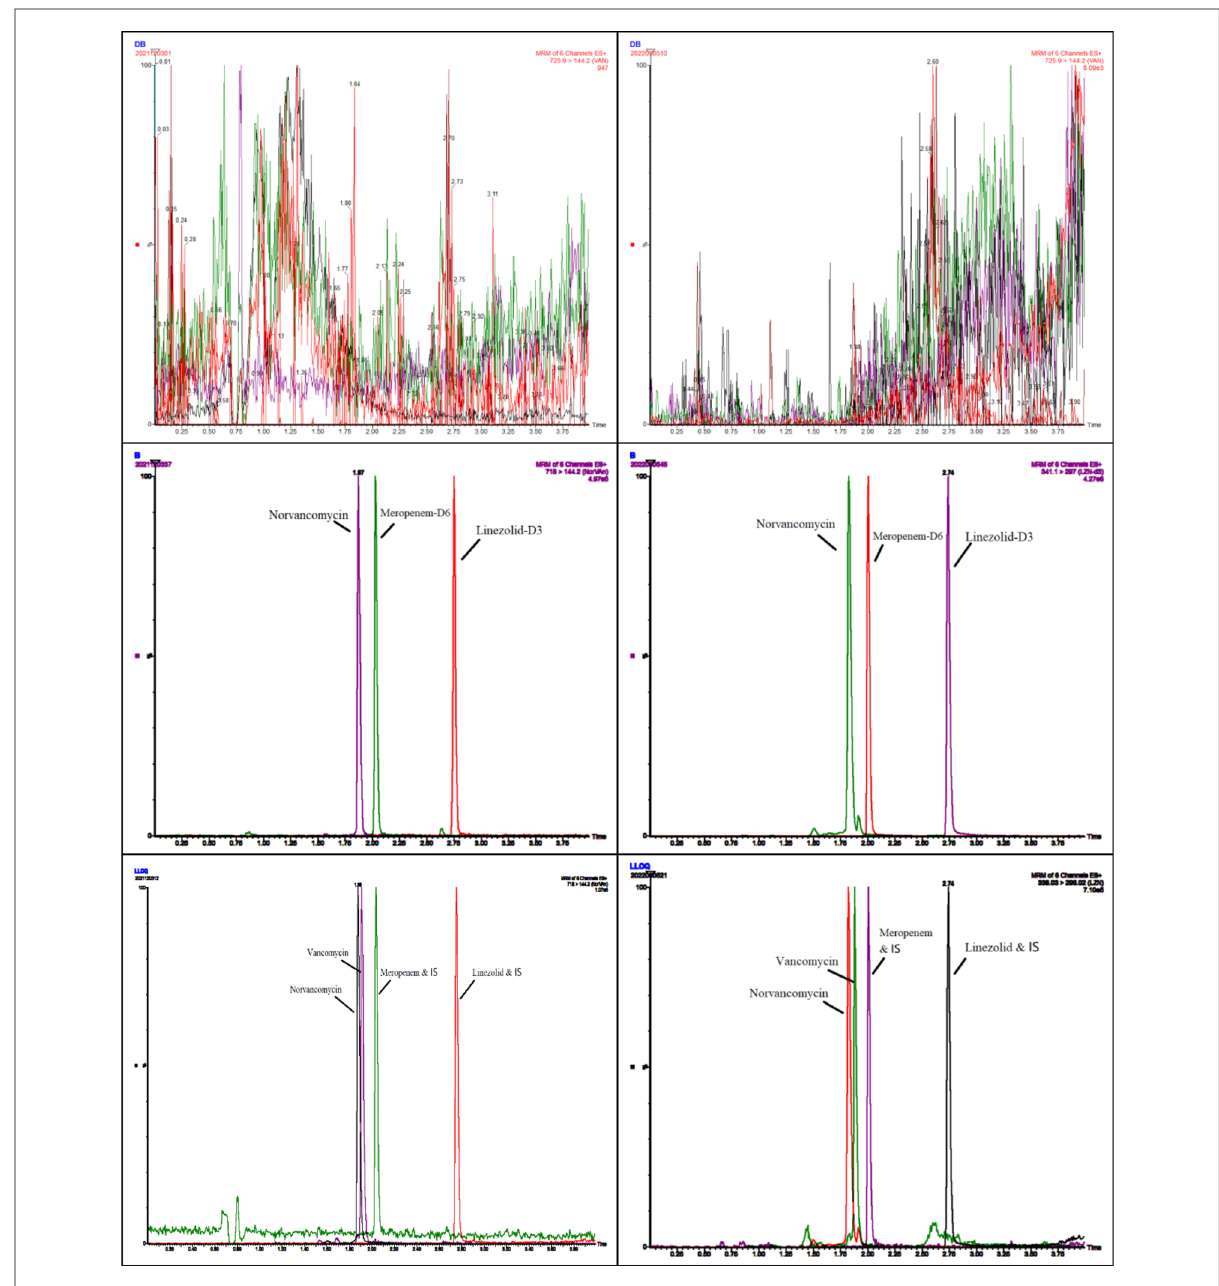
FIGURE 1 Representative chromatograms of blank, internal standard, and lower limit of quanti fi cation (LLOQ) of vancomycin, meropenem, and linezolid obtained from plasma (left) and DBSs